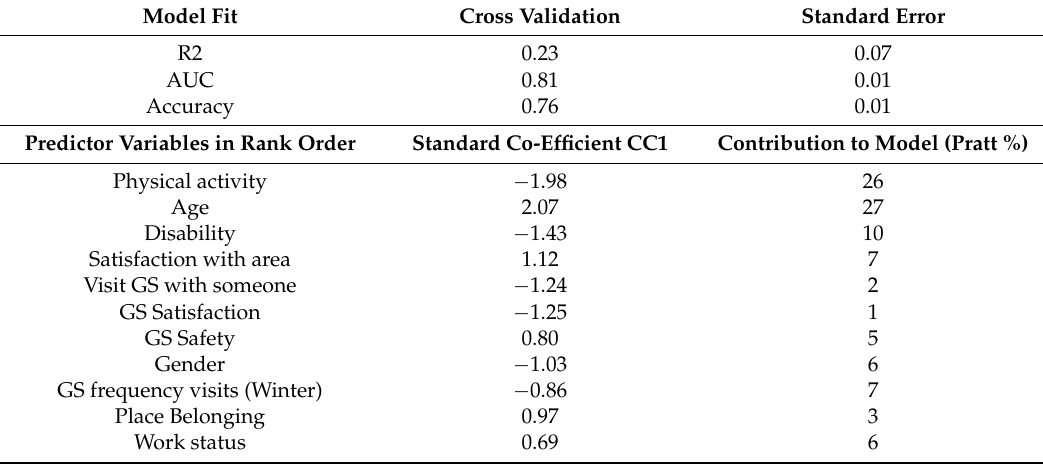
Table B3. CCR model fit and standard coefficients for predictors of “poor” general health, Mixed BME (people of African-Caribbean, Bangladeshi, Pakistani origin, Other